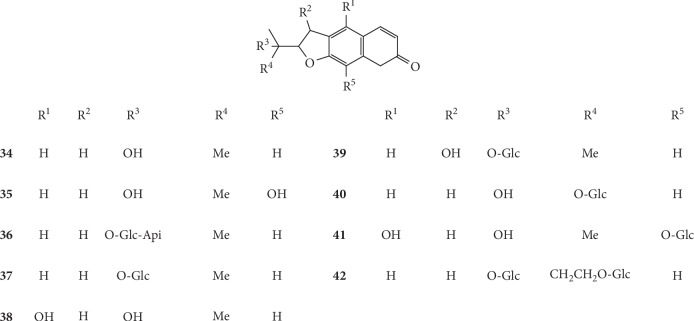
Structures of furanocoumarins in G. littoralis.